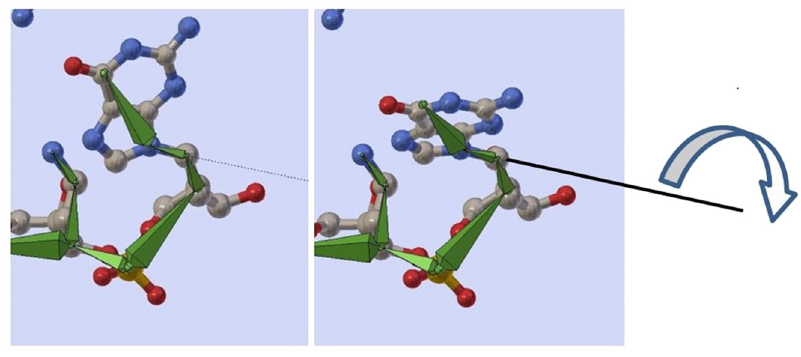
Figure 6: A possible skeletal animation for the atomic model of guanine. The groups of atoms for macromolecules may be defined and moved by bones to provide intuitive modeling such as dihedral rotations, which we plan to address in